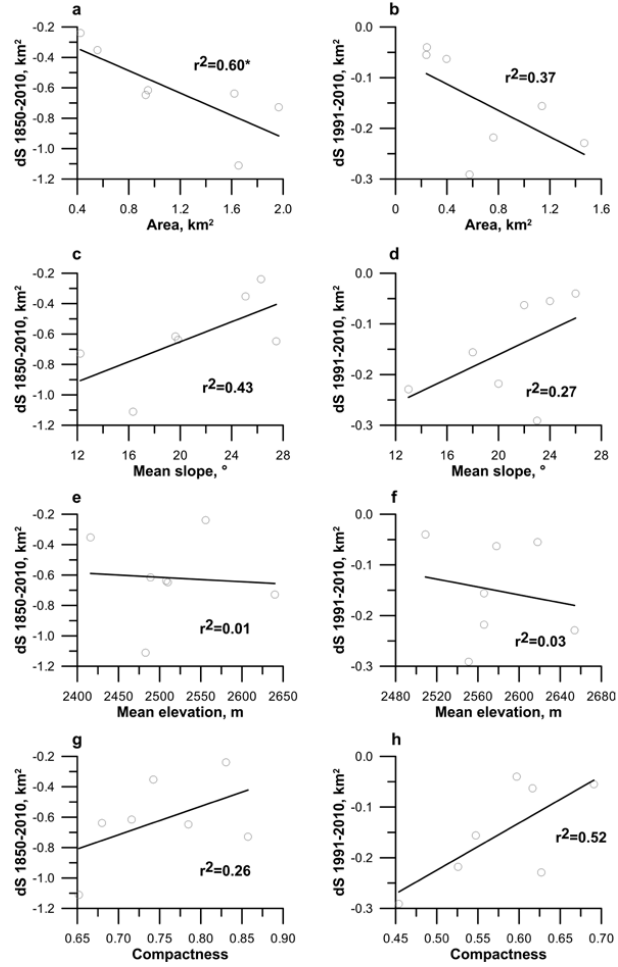
Figure 5. Relationships (linear regression) between absolute and relative ice area changes (dS) in 1850–2010 and 1991–2010 and initial area ( a , b ), mean slope ( c , d ), mean elevation ( e , f ) and compactness ( g , h ) of glaciers. The statistically significant relationship ( p < 0.05) is indicated by an asterisk.